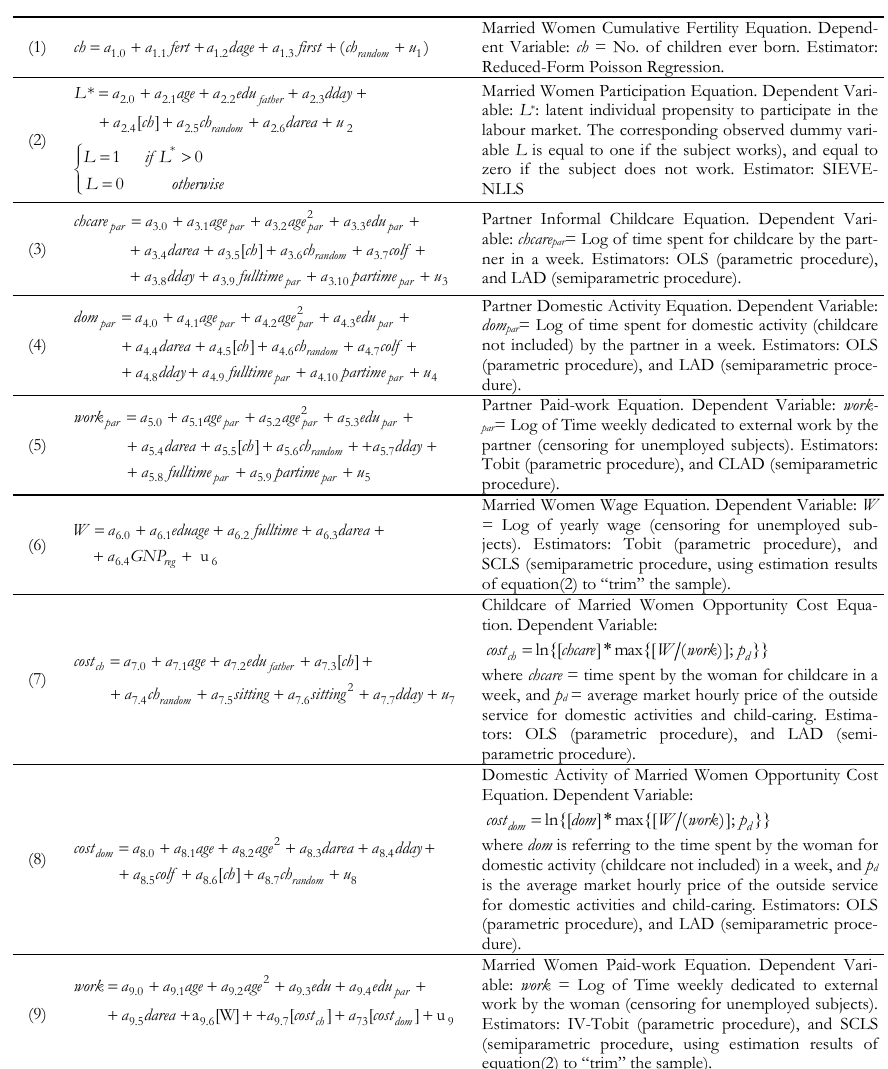
Simultaneous equation model specification